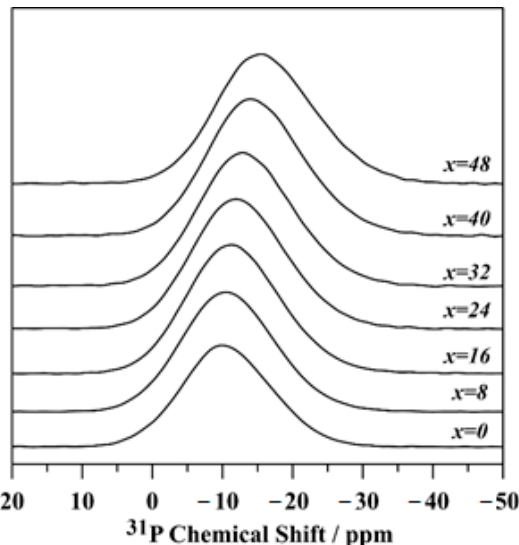
Figure 6. The 31 P MAS NMR spectra of the glass series (100 − x)[0.4Na 2 O-0.2Nb 2 O 5 -0.4P 2 O 5 ]-xB 2 O 3 .